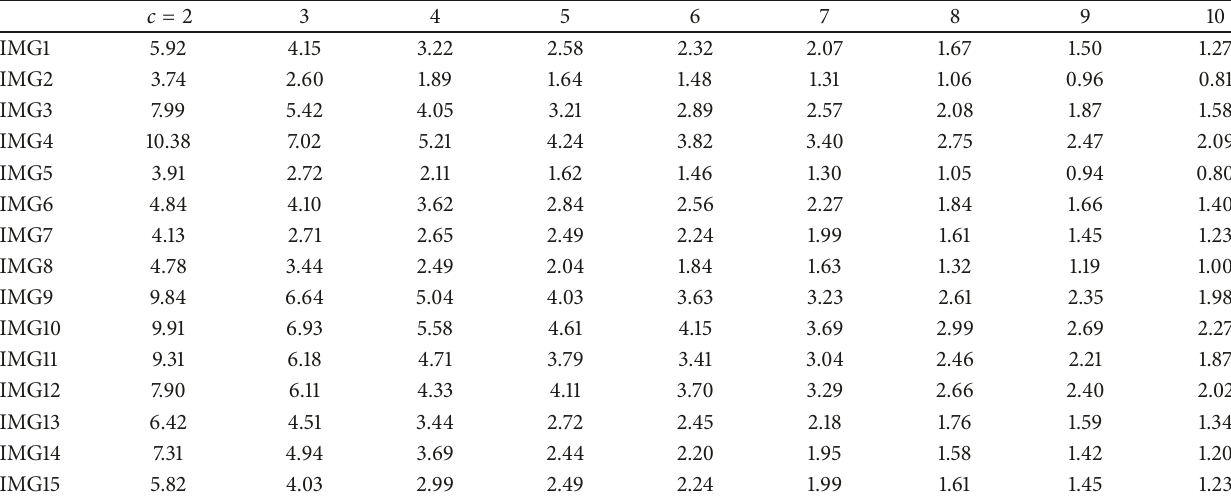
Table 8: MSE ( ×10 3 ) using FCM with different cluster number.